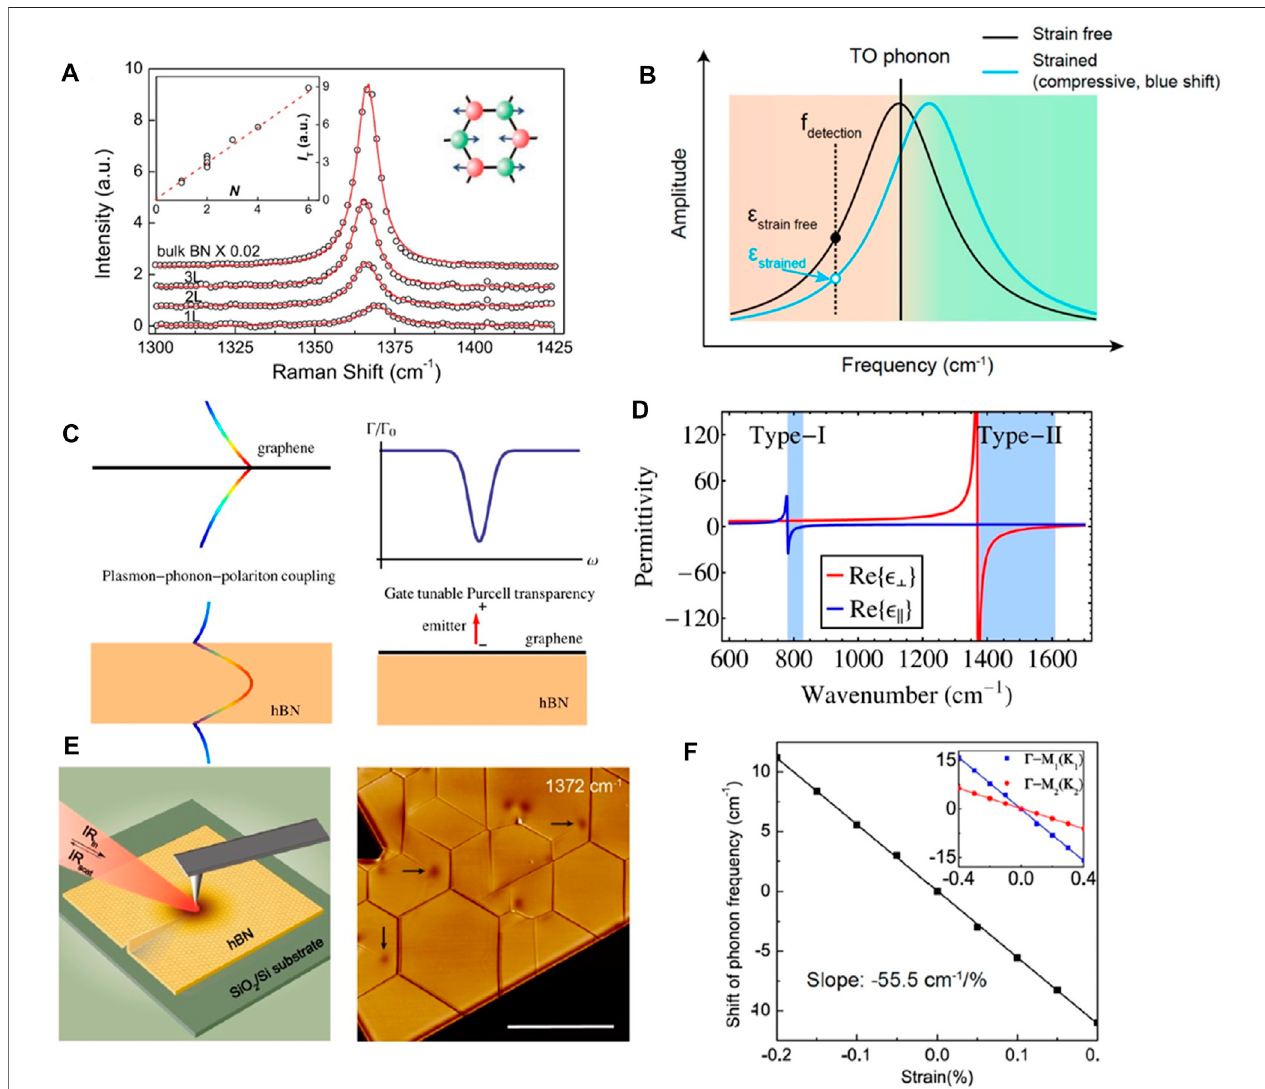
FIGURE4|(A) RamanspectraofhBN.Insetshowsthechangesinintegratedintensitywiththelayernumber.Thepictureinthetoprightsideshowsphononmode for Raman peak [adapted and modi fi ed from (Lyu et al., 2019)]. (B) Illustration of compressive strain induced phonon frequency shift and near- fi eld IR contrast [adapted andmodi fi edfrom(Lyuetal.,2019)]. (C) TheinteractionofgrapheneplasmonwithhBNphonon (left) andemissionofanearbydipoleintohybridmodes (right) [adapted and modi fi ed from [(Kumar et al., 2015)]. (D) Permittivity of hBN [adapted and modi fi ed from (Kumar et al., 2015)]. (E) The near- fi eld IR measurement technique using hBN [adapted and modi fi ed from (Lyu et al., 2019)]. (F) Theoretical results of phonon frequency as a function of isotropic strain [adapted and modi fi ed from (Lyu et al.,